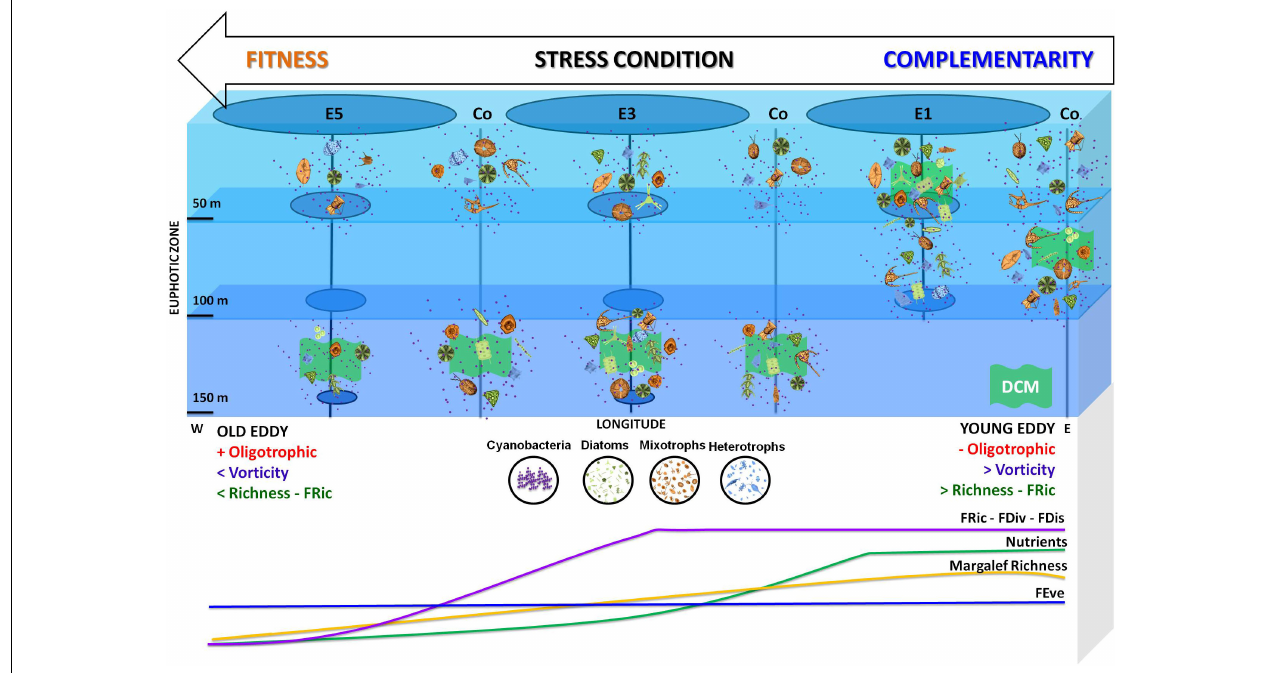
FIGURE 7 | The conceptual distribution model of microplankton richness, trophic mode, and functional diversity indices (FRic, FEve, FDis, and Fdiv) in Agulhas eddies of different